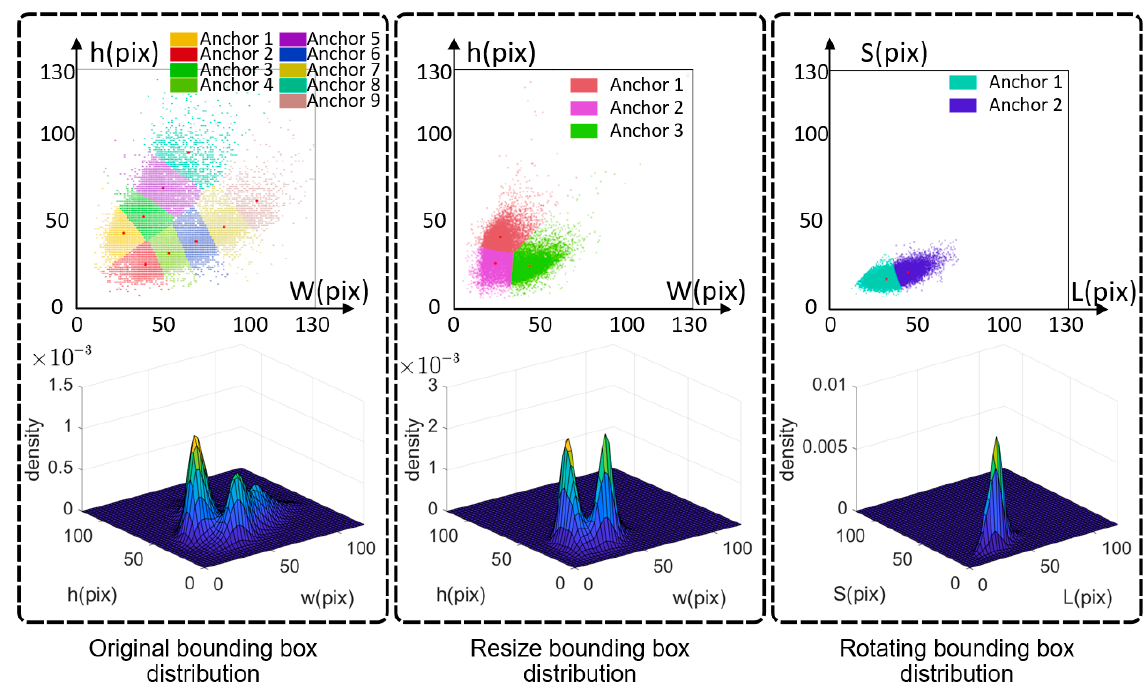
13 of 23 Table 2. Comparison of different optical remote sensing datasets. Dataset